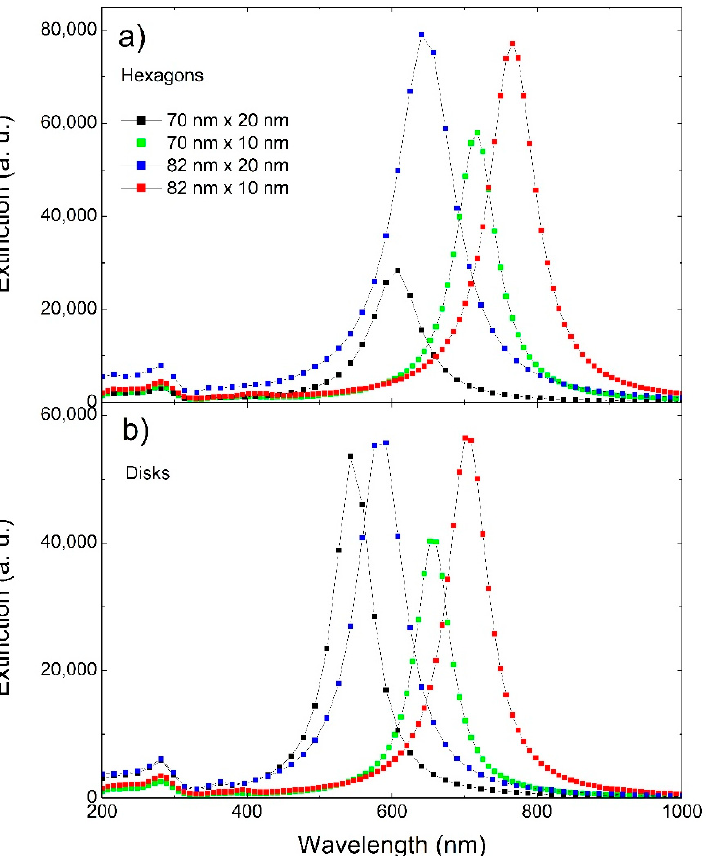
Figure 5. Simulated extinction spectra for ( a ) hexagons and ( b ) disks of 70 nm and 82 nm in size and 10 nm and 20 nm in thickness.